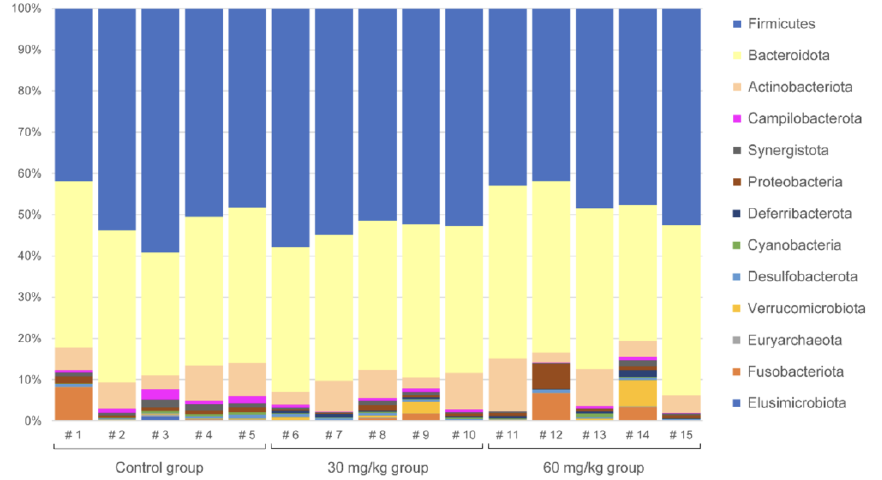
Figure 2. Phylum-level composition of the cecal microbiota in chicken. Three groups (five replicates in each group) represent the different treatments, as indicated.